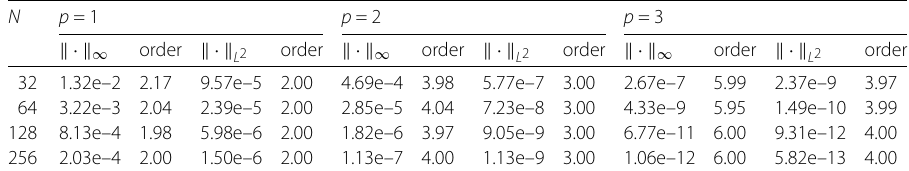
Table 8 Improved graded mesh, λ = 2, τ (cid:2) = min { 0.5,– (cid:2) ( p + 1)ln (cid:2) } , (cid:2) = 10 –8